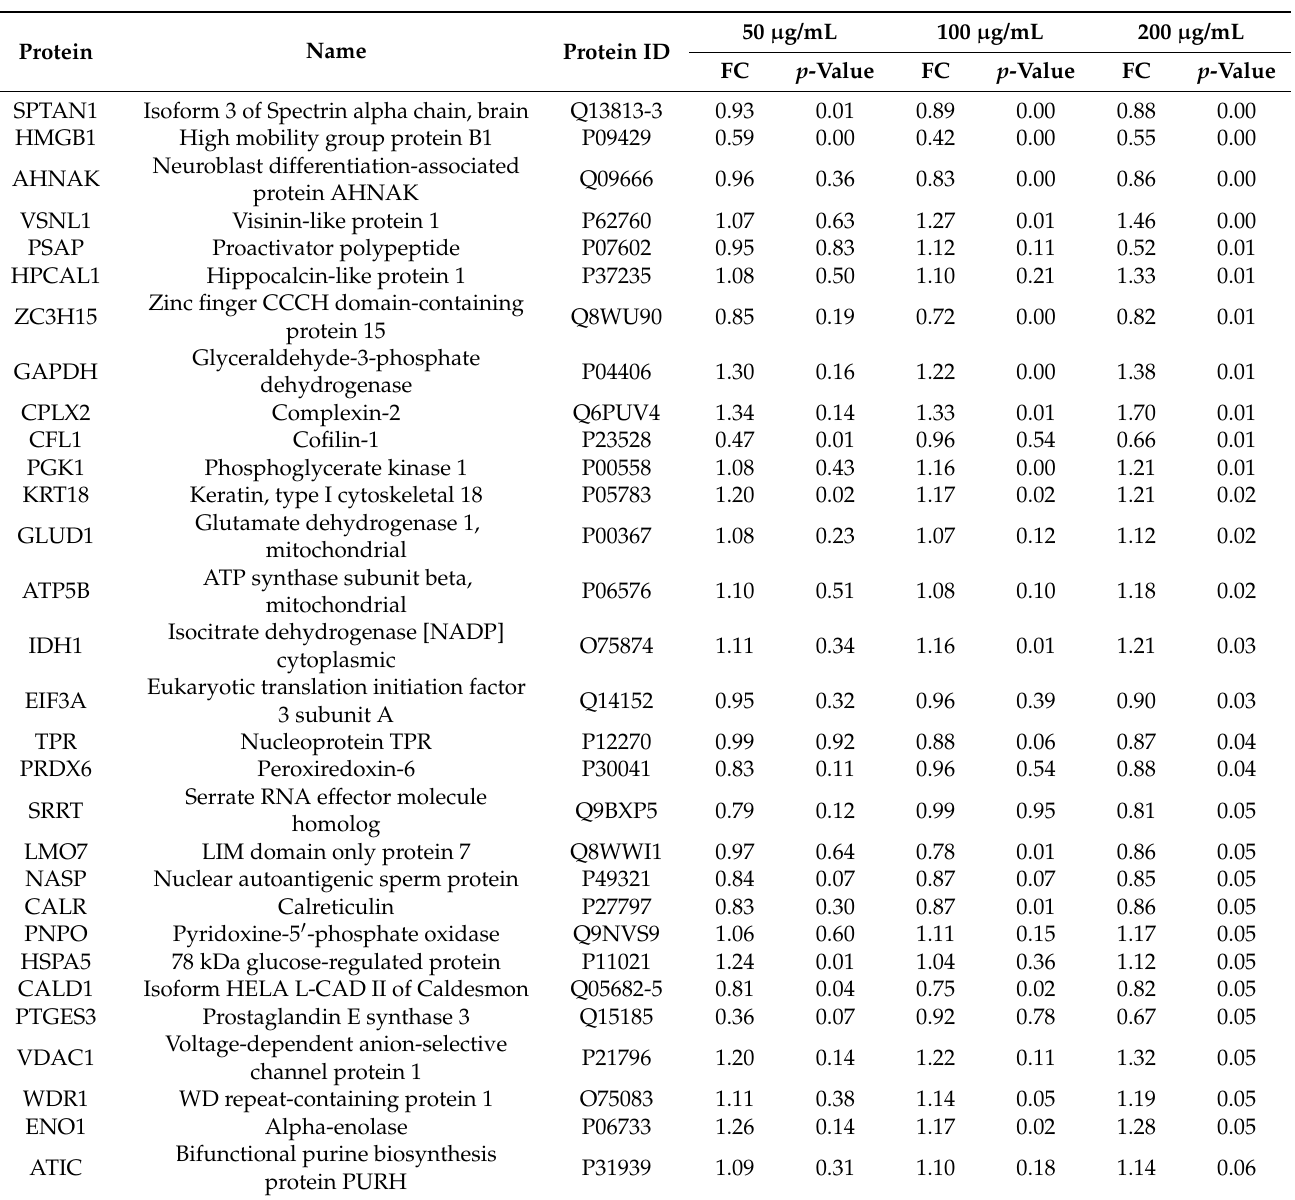
Table 1. Differentially expressed proteins between control and chlorogenic acid treatment groups by iTRAQ